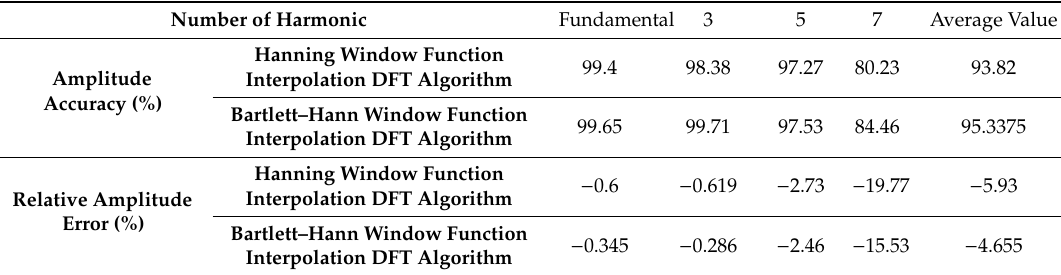
Table 4. Comparison table of analysis results of two